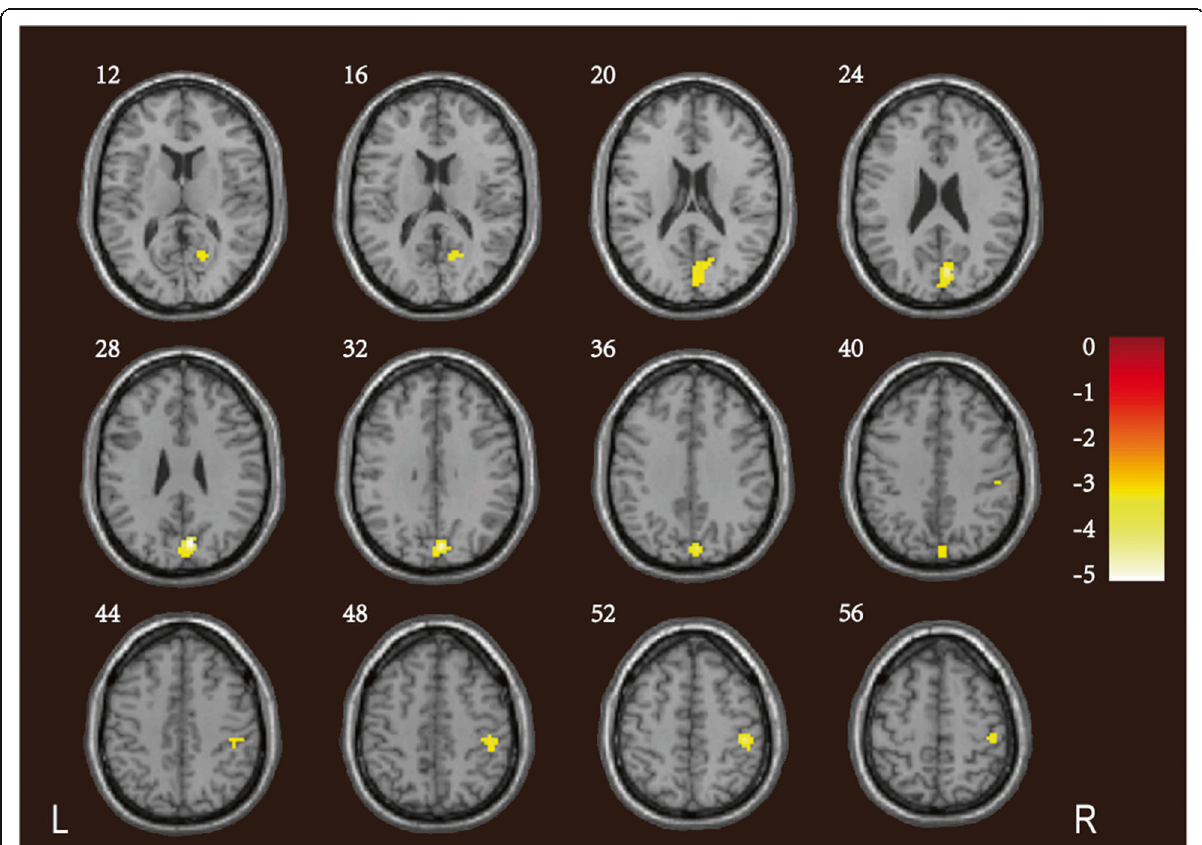
Fig. 2 Reductions in the ReHos in patients with CADASIL. The CADASIL group exhibited significantly lower ReHos in the right Pcu/CU, visual association cortex, calcarine gyri, posterior cingulate and limbic lobe, compared to controls. The t- values are color-coded. ReHo: regional homogeneity; CADASIL: cerebral autosomal dominant arteriopathy with subcortical infarcts and leukoencephalopathy; Pcu/CU: precuneus and cuneus